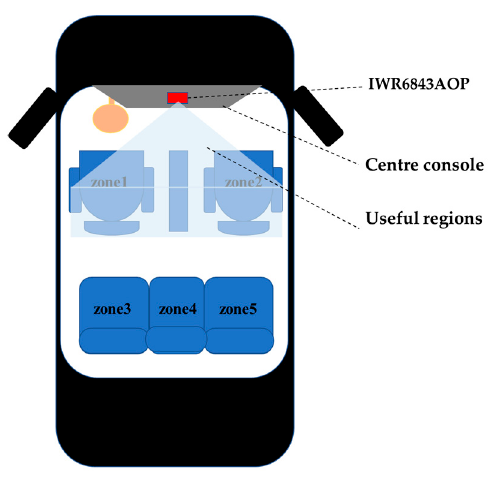
Figure 3. Experiment environment.